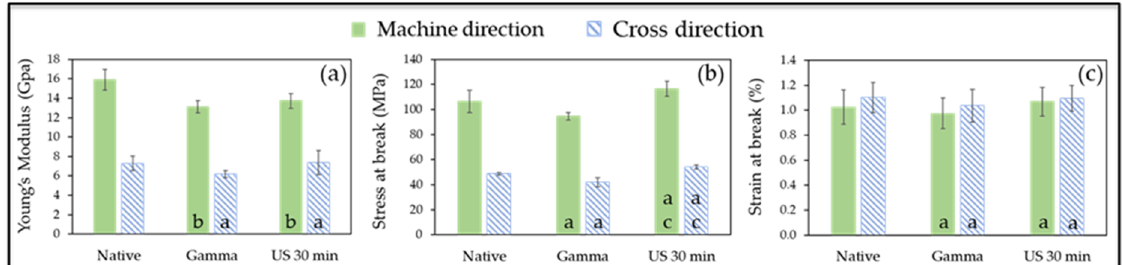
Figure 10. Tensile test results for ( a ) Young’s modulus; ( b ) stress at break; ( c ) strain at break; Gamma column: If value is different compared to Native ( p value < 0.05), letter b; otherwise letter a; US 30 min column: If value is different compared to Native, letter b otherwise letter a and if value is different compared to Gamma, letter c, otherwise left blank.